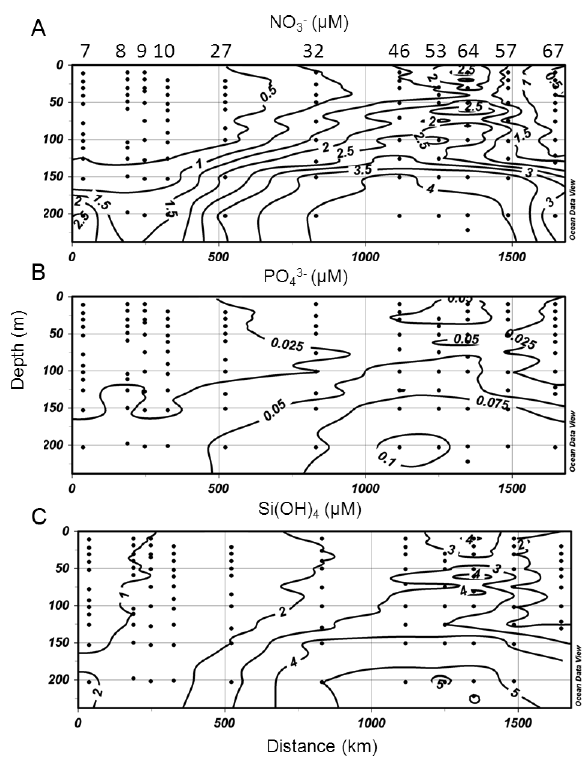
Fig. 3. Vertical distribution of (A) nitrate (NO − (PO 3 − ) and (C) silicate (Si(OH) 4 ) down to 200m along the cross 4 Fig. 3: Vertical distribution of (A) nitrate (NO 3- ), (B) phosphate (PO 43- ) and (B) Silicate (Si(OH) 4 ) down to 200 section through the eastern Mediterranean Sea (similar to Fig. 2). m along the cross section through the eastern Mediterranean Sea (similar to Fig. 2). Stations are indicated on the Stations are indicated on the top of the x top of the x axis.